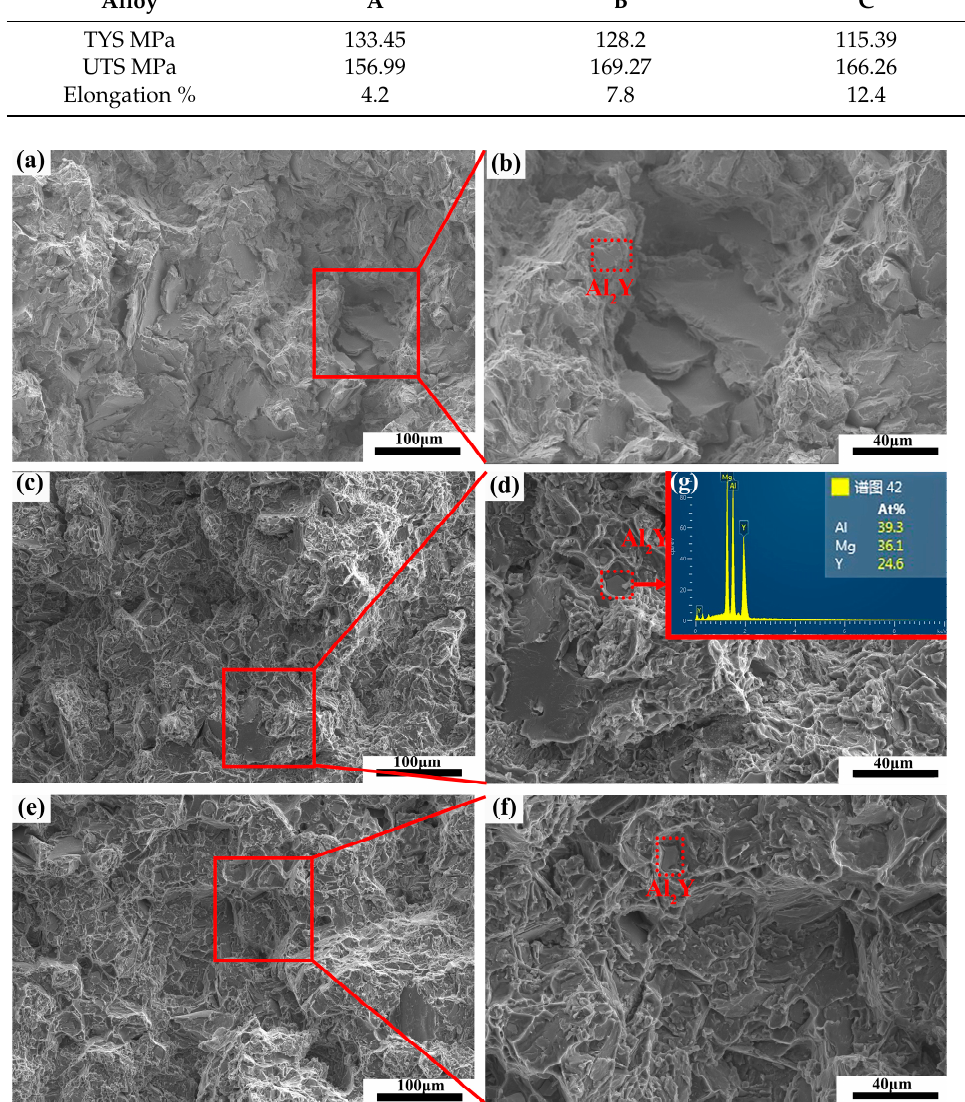
Figure 10. The SEM images of tensile fractures of Mg-1Al-12Y alloy under different tensile